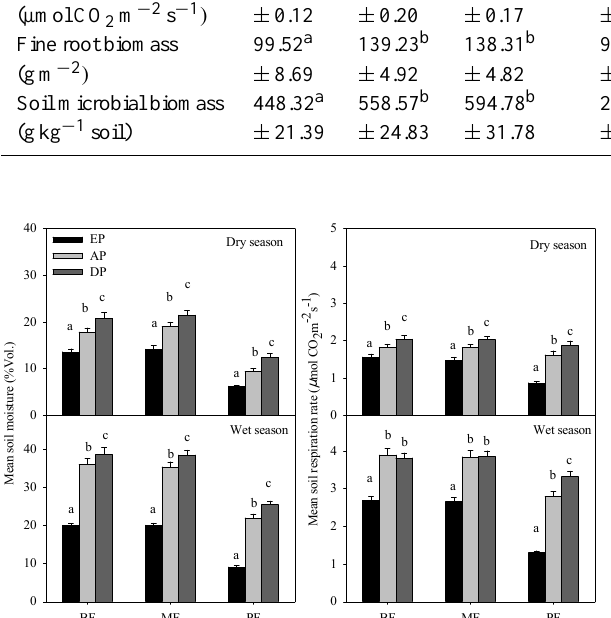
Fig. 2. Mean values of soil moisture and soil respiration rate un- der different seasons and different precipitation treatments at the DNR forests. The treatments are as follows: precipitation exclusion (EP), ambient precipitation (AP), and double precipitation (DP). The forests are as follows: broadleaf forest (BF), mixed forest (MF), and pine forest (PF). Error bars are standard